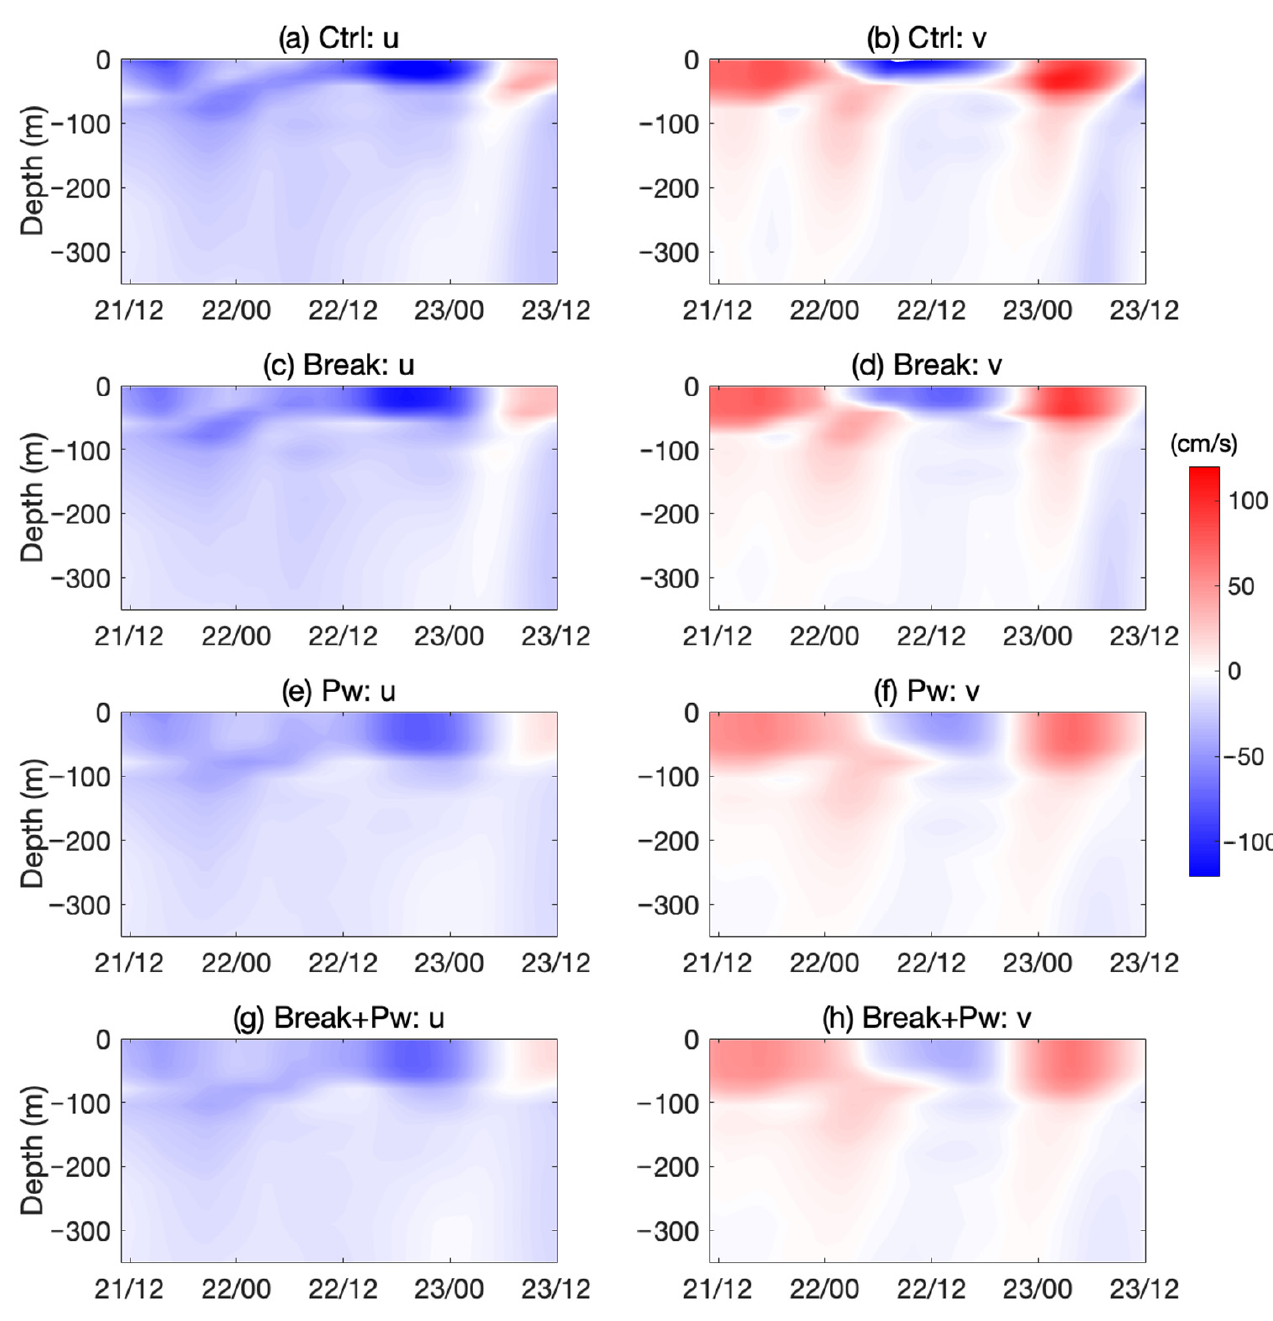
Figure 8. The modeled currents (removed tides) of four experiments at the location of the left mooring. Left and right panels display the eastward component (u) and the northward component (v) of current velocity, respectively.